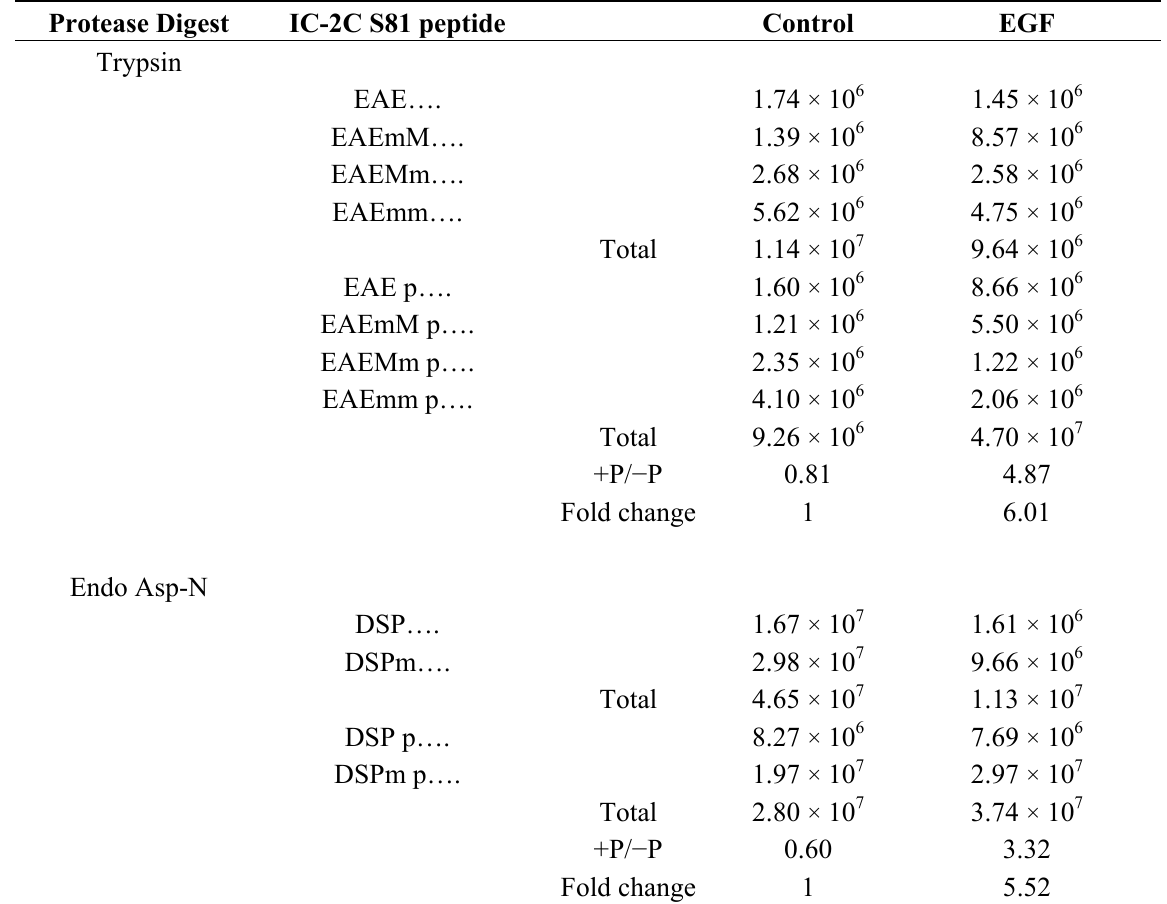
Table 2. Identification of Serine 81 phosphorylation after Trypsin or endo Asp-N